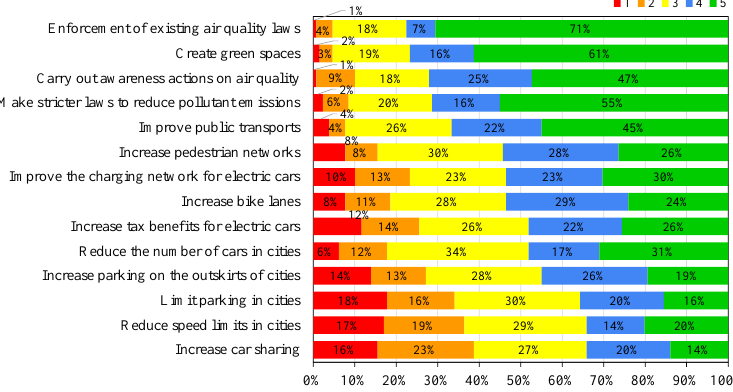
Figure 13. Degree of priority given by the citizens of the UFSAAPP population to different measures to improve air quality (ranging from 1 for “minimum priority” to 5 for “maximum priority”).